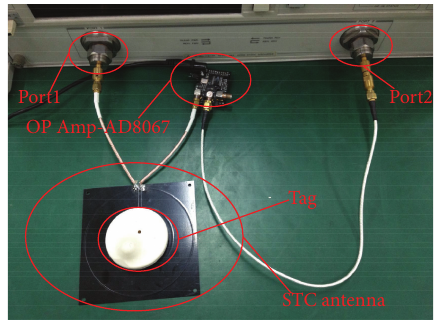
Table 2: The test result of quality